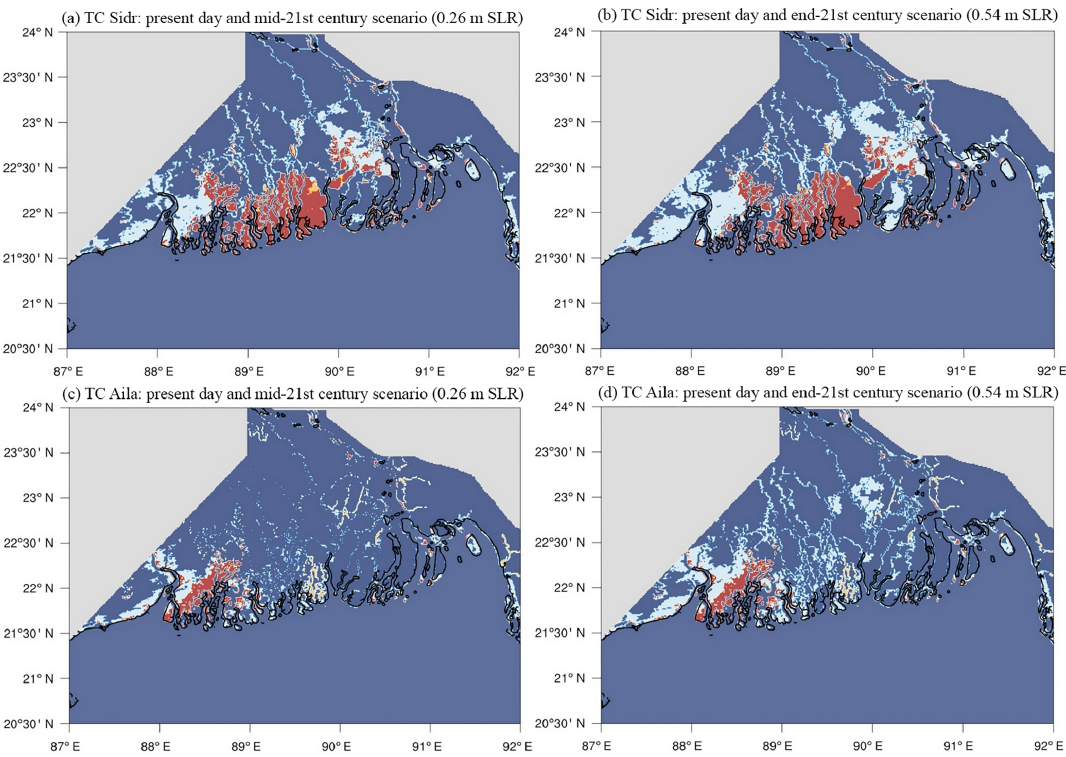
Figure 5. Comparison of the inundated areas between present-day and future climate scenarios for (a) TC Sidr mid-21st century 0.26m SLR, (b) TC Sidr end-21st century 0.54m SLR, (c) TC Aila mid-21st century 0.26m SLR and (d) TC Aila end-21st century 0.54m SLR. White represents the flooded areas that were not in the present-day scenario but were flooded due to future SLR. Red shows the inundated areas that were similar both for present-day and future SLR